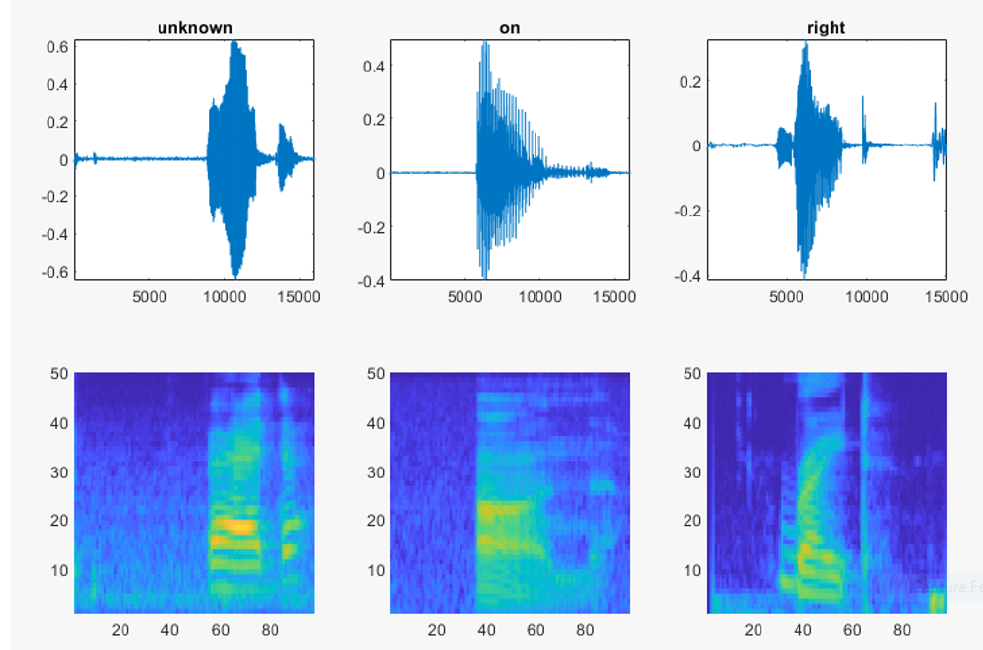
Figure 3. From audio signals to